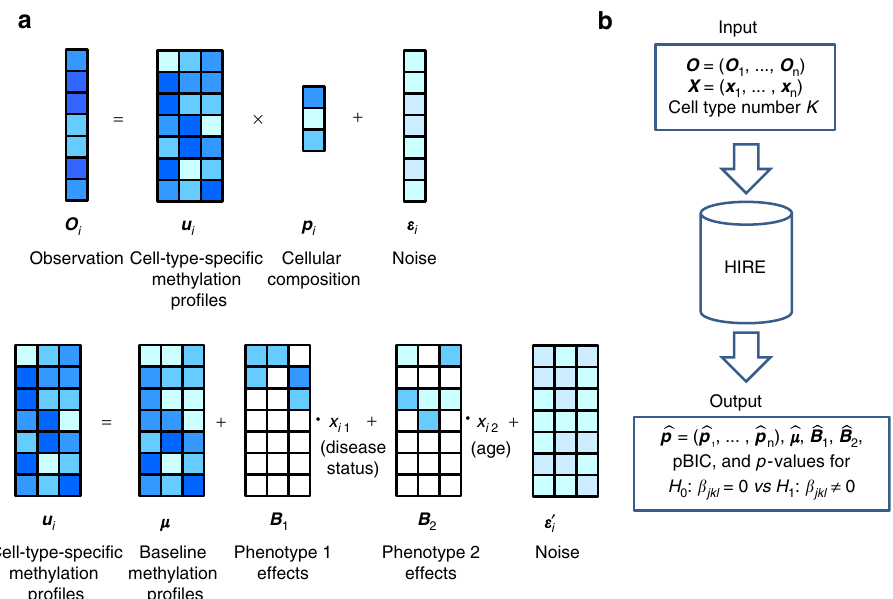
Fig. 1 A simple cartoon illustration of the HIRE model with three cell types ( K = 3) and two phenotypes (disease status and age; q = 2). a Data generation procedure for the observed methylation vector O i for sample i ( i = 1, … , n ). In the top panel, O i is the convolution of cell-type-speci fi c methylation pro fi les u i with cellular compositions p i . Both u i and p i depend on the attributes of sample i . The bottom panel describes how sample i ’ s phenotypes affect u i via two phenotype-effect matrices B 1 and B 2 . In B 1 and B 2 , the white square represents zero, which indicates that the phenotype exerts no in fl uence on the corresponding methylation level in u i . b Inputs and outputs of HIRE. We input the observed methylation matrix O , the phenotype data matrix X , and a predetermined cell type number K into HIRE, and HIRE outputs the estimates for the cellular compositions b p , the baseline methylation pro fi les b μ , the phenotype effects b B ‘ , and the penalized BIC value. In addition, HIRE tests whether there is any association between CpG site j and phenotype ‘ in cell type k —